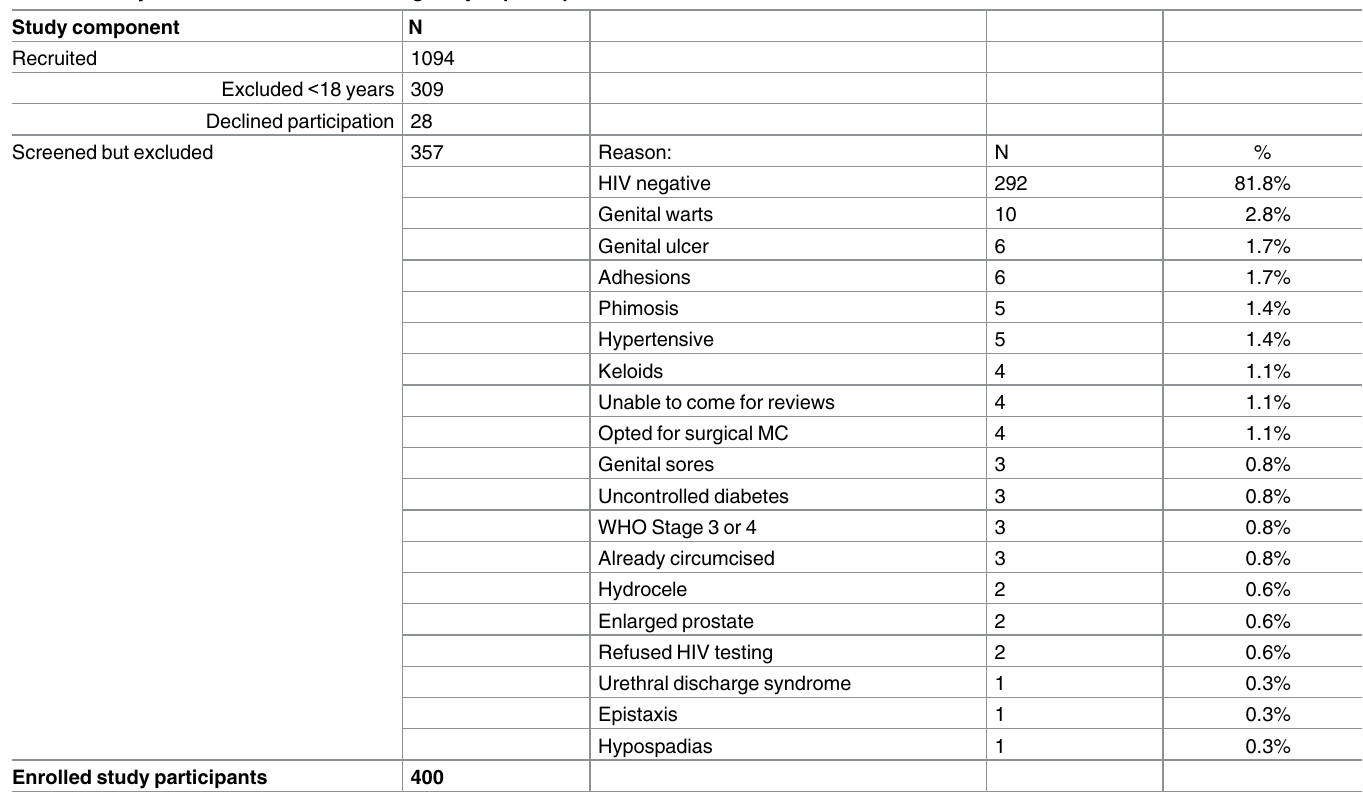
Table 1. Study flow and reasons for non-eligibility of